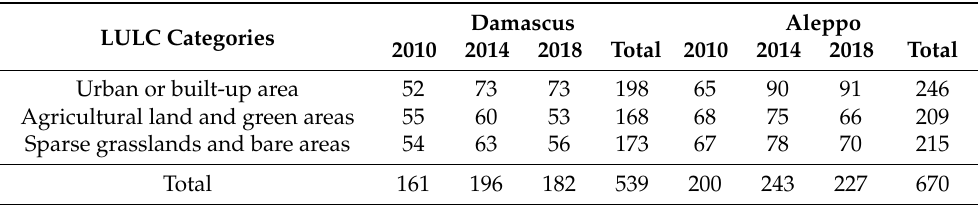
Table A1. Number of samples (Polygons) of each LULC class used to train the classifier in 2010, 2014, and 2018 in Damascus city and Aleppo city.